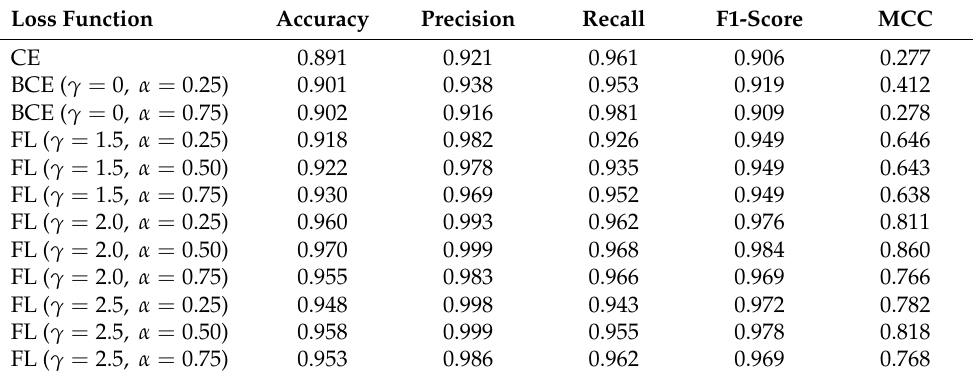
Table 4. Classification results with HSI dataset for varying cost functions and respective parameter sets. (patch size parameter S = 100, 3D convolutions, see Figure A1 for network topology). Loss Function Accuracy Precision Recall F1-Score MCC 0.891